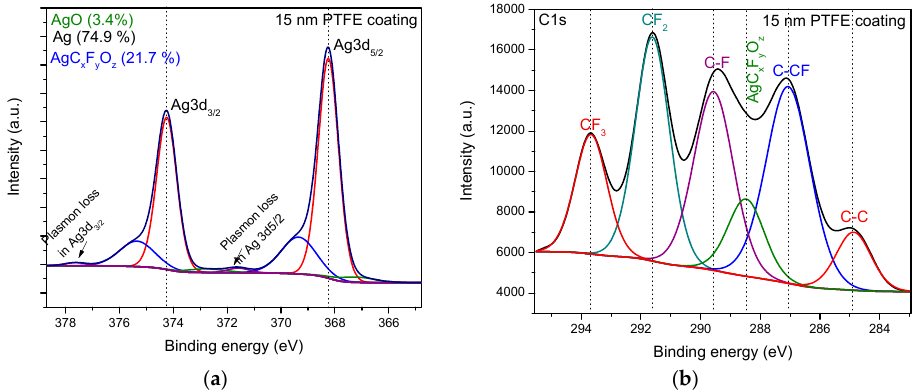
Figure 5. High-resolution spectra of ( a ) Ag 3d and ( b ) C 1s binding energy regions for 15 nm thickness of PTFE topcoat layer and their corresponding deconvolutions presenting the bonding types in the nanocomposite material.